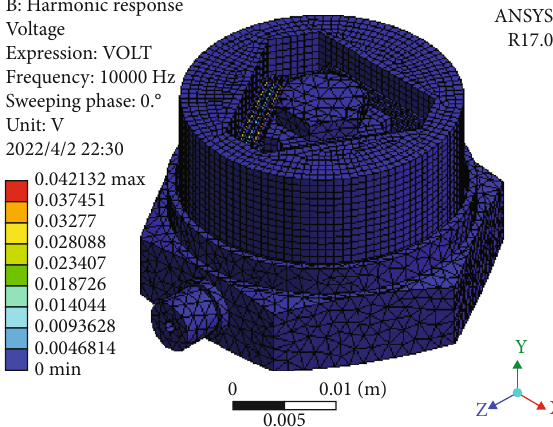
Figure 10: Voltage distribution diagram for case 1.